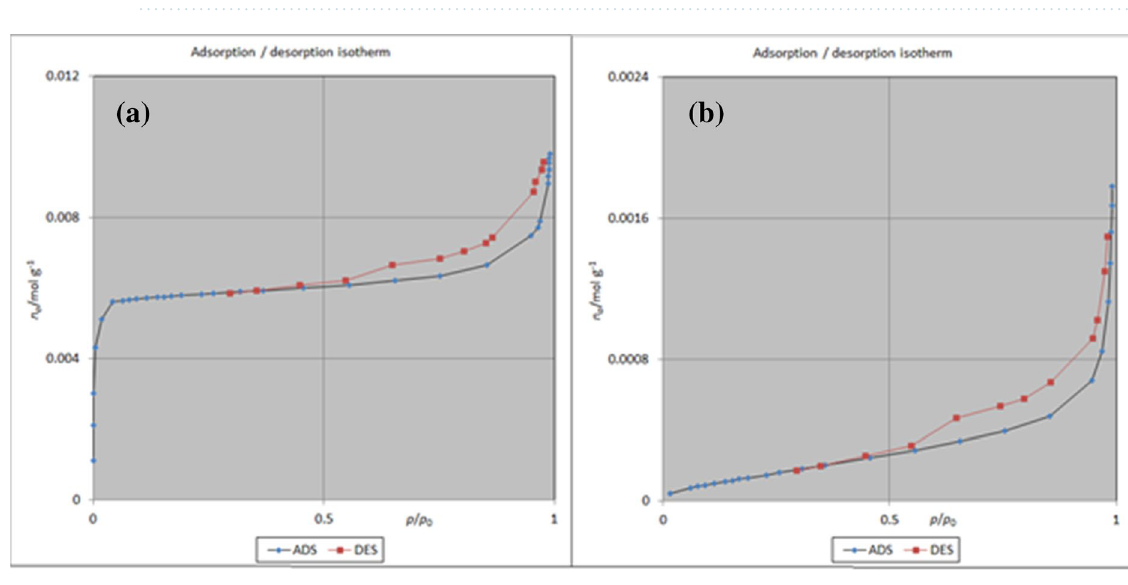
Figure 8. Adsorption / desorption of ZIF-8/ GO/MgFe 2 O 4 (a) , and ZIF-8/GO/MgFe 2 O 4 /TC (b)